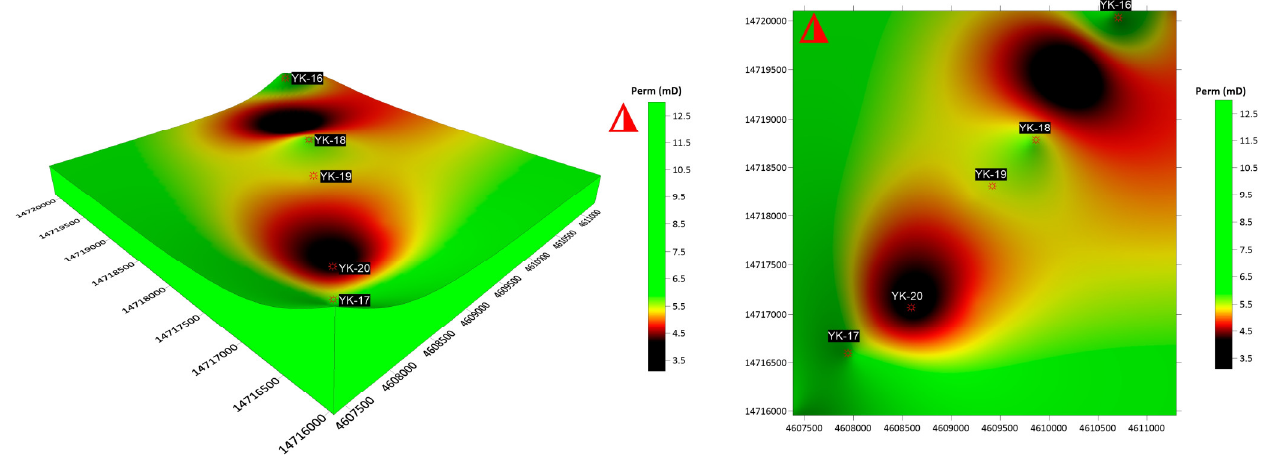
Figure 16. Permeability distribution map.